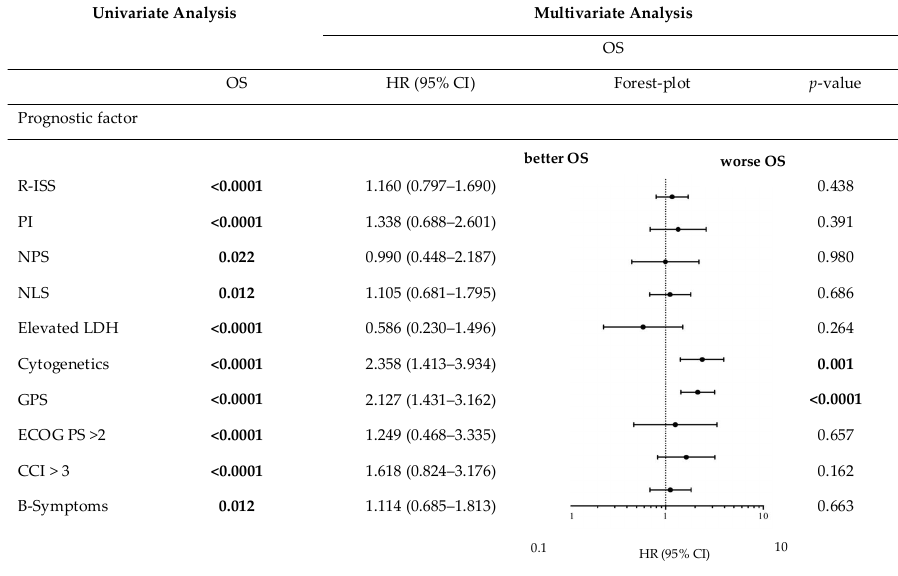
Table 8. Overall survival in univariate analysis and consecutive multivariate Cox proportional hazard regression.